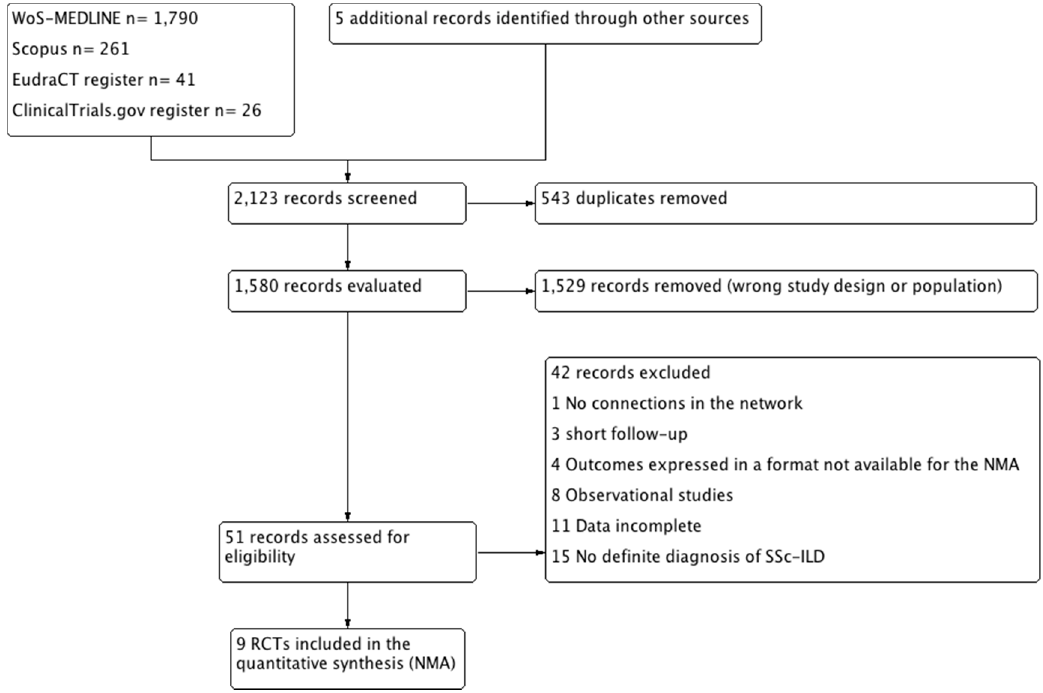
Figure 1. Flowchart. SSc-ILD, systemic sclerosis-related interstitial lung disease; RCTs, randomized controlled trials; NMA, network meta-analysis.